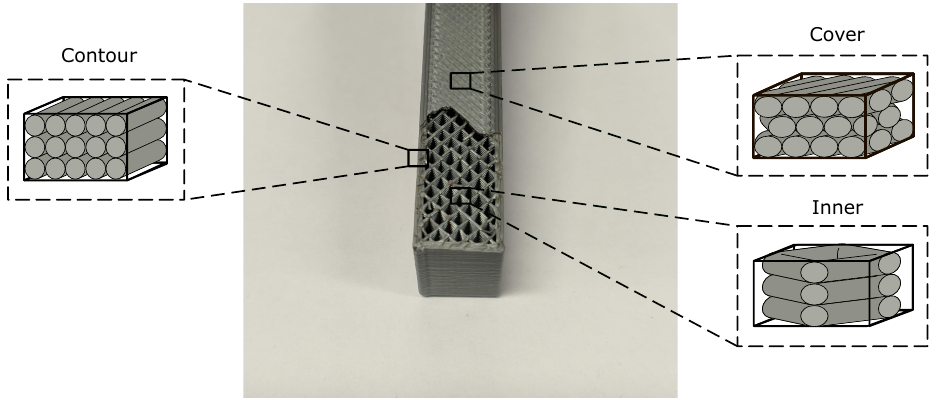
Figure 1. Zone distinction of a 3D-printed